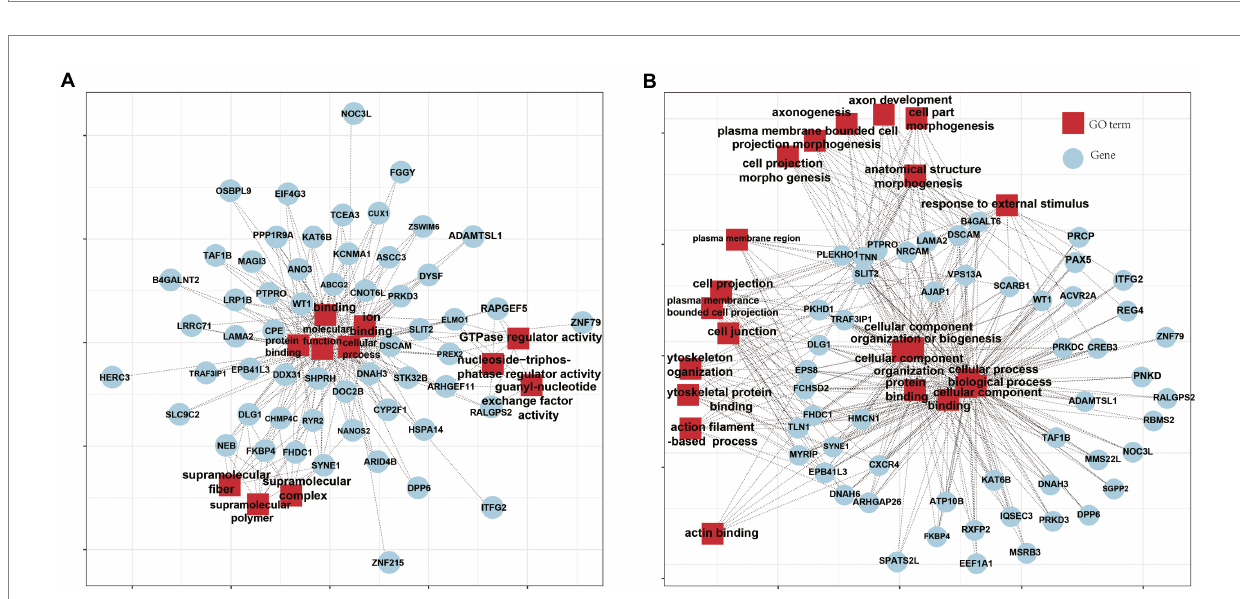
FIGURE 6 Selective sweep gene GO analysis at the last 5% threshold of YEC (66) and DUL (60). (A) GO analysis was performed on 66 candidate genes obtained by selective sweep of YEC, and they mainly focused on molecular function, protein binding and ion binding. (B) GO analysis was performed on 60 candidate genes obtained by selective sweep of DUL, and they mainly focused on anatomical structure morphogenesis, plasma membrane bounded cell projection and cell